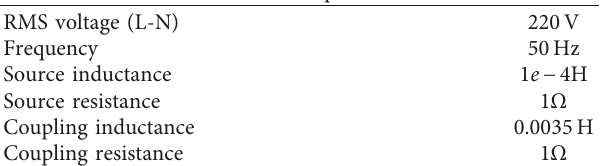
Table 3: Circuit